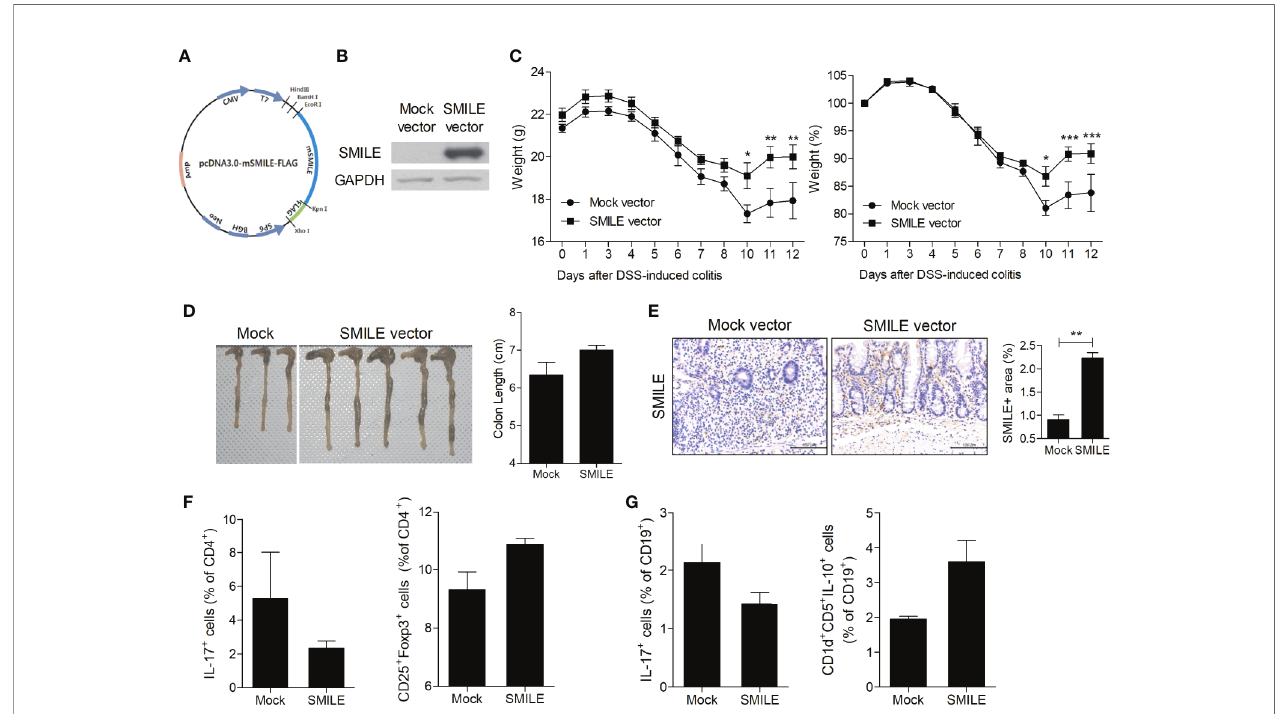
FIGURE 2 | SMILE overexpression vector reduced the susceptibility of mice to DSS-induced colitis. (A) Vector map showing restriction sites and the SMILE site. (B) Lysates of HT-29 cells transfected with MOCK and SMILE overexpression vectors were analyzed for SMILE protein by western blotting with an anti-SMILE antibody. (C) Changes in body weight (n = 5 per group). (D) Macroscopic images of the colon and colon lengths. (E) Colon tissue stained with an anti-SMILE antibody. Representative images are shown. Bars are percentage positive areas per fi eld. (F) Th17 and Treg cells and (G) IL-17- and IL-10-producing B cells in MLNs by fl ow cytometry. Data are means±SEM of two replicates. * P < 0.05, ** P < 0.01, *** P <